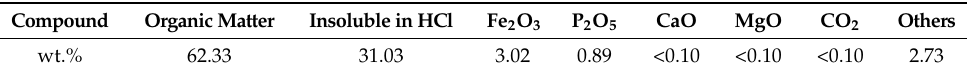
Table 1. Composition of the dry deposit collected from the membrane surface.